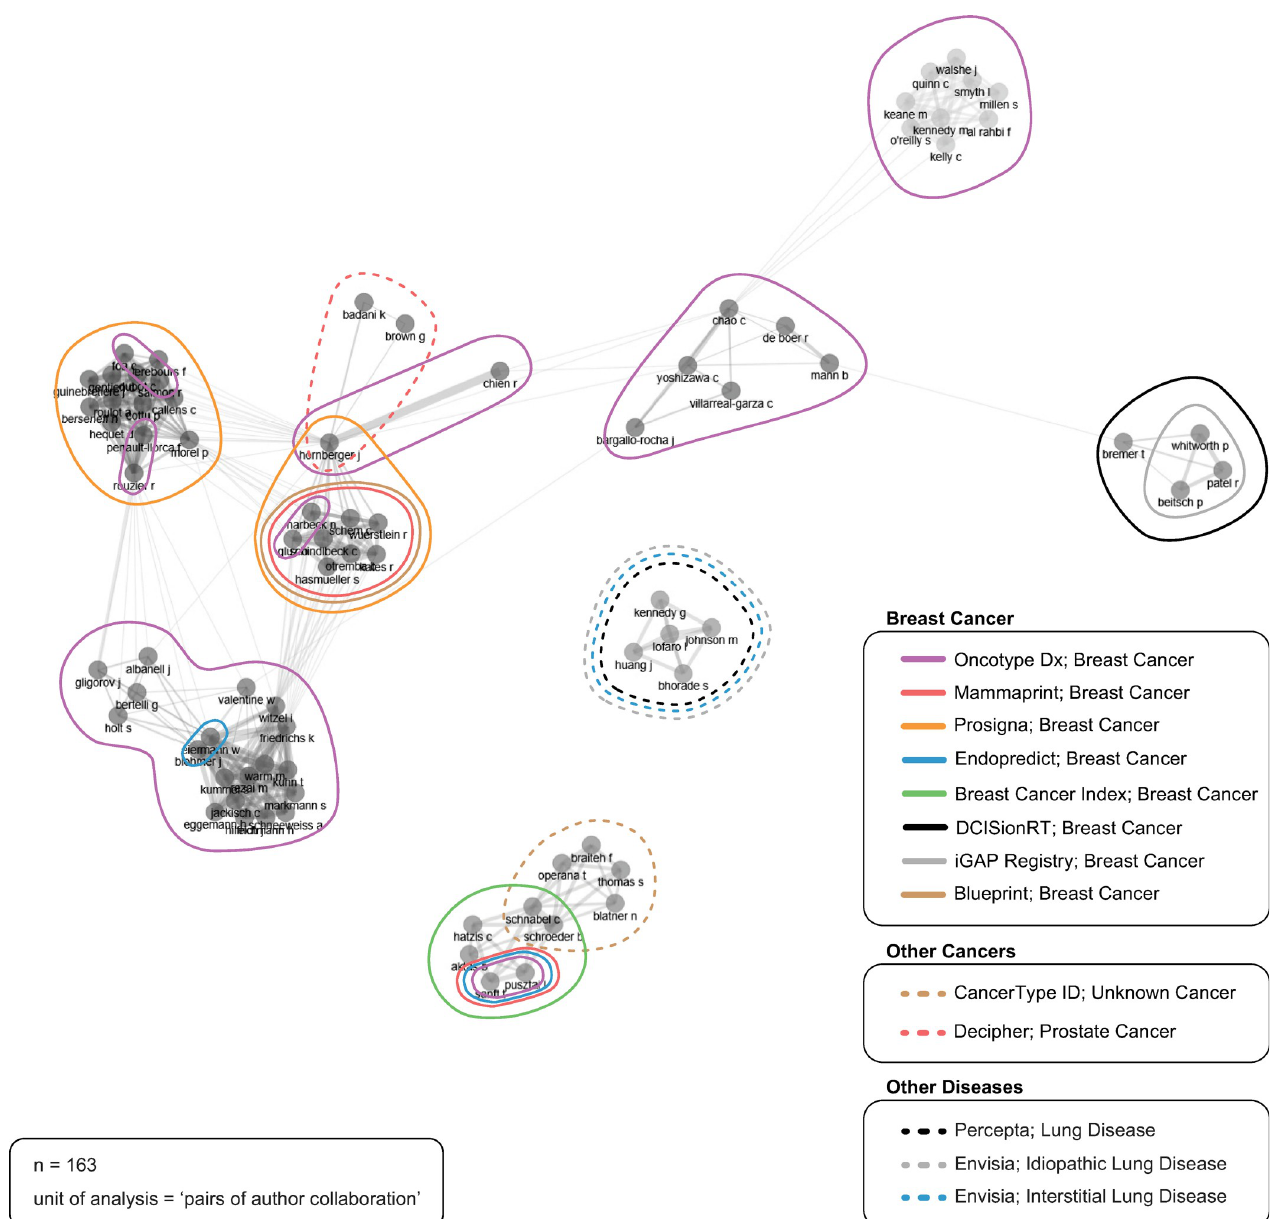
Fig 6. Author collaboration networks. Source: R-based application Biblioshiny was used; additional analysis (i.e., publication focus) completed by the study authors and applied to the visualization using Adobe Illustrator. Parameters specified: network layout = automatic layout (default); clustering algorithm = walktrap (default); normalization = association (default); number of nodes = 92 (top 10% of total authors); repulsion force = 0.1 (default); remove isolated nodes = yes (default); minimum number of edges (i.e., connections) = 1 (default).